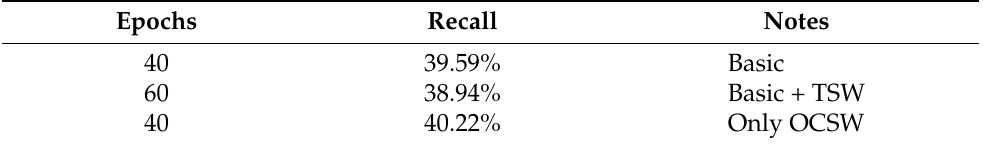
Table 5. Experiment results of